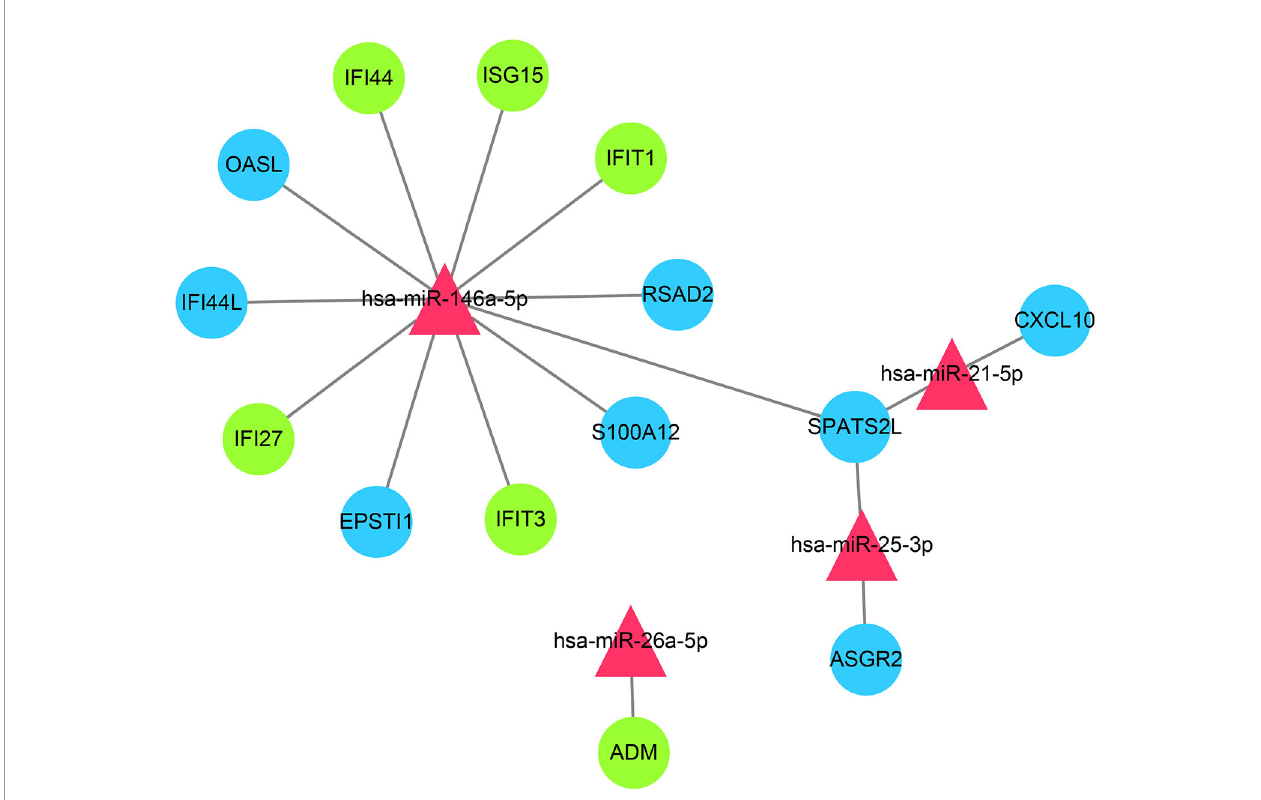
FIGURE 8 | miRNAs – shared genes regulatory network. Red triangles represent miRNAs, and blue circles represent shared genes, green circles represent overlapped shared